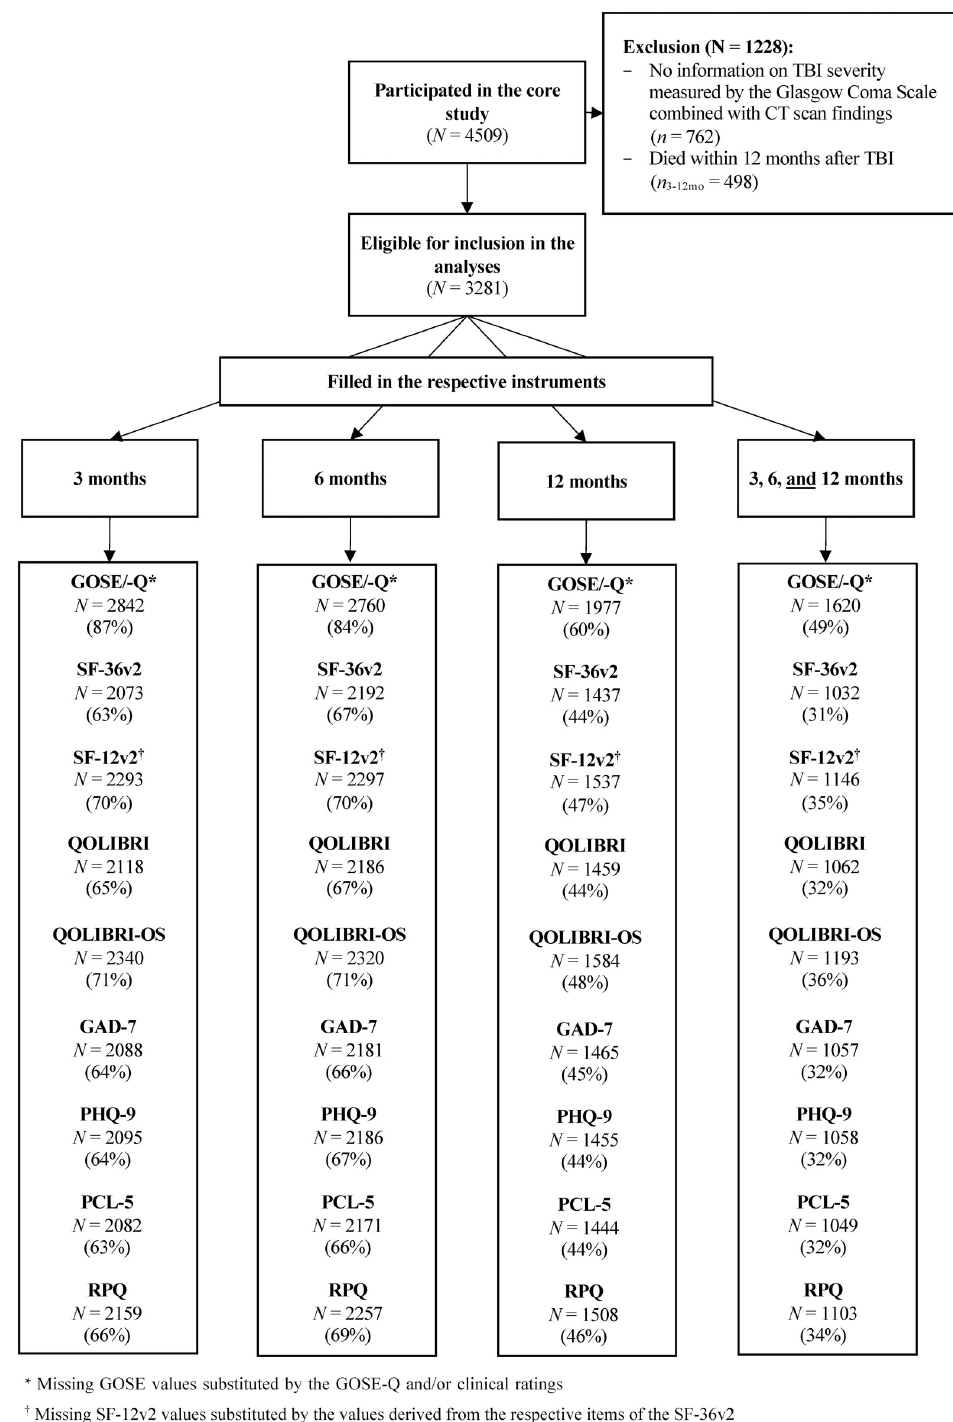
Fig 2. Numbers of completed instruments per time point (3, 6, and 12 months after TBI) and for all time points completed by the same individuals. GOSE/-Q = Combined information on recovery status using the Glasgow Outcome Scale–Extended and its questionnaire version; SF-36v2 = 36-item Short Form Health Survey–version 2; SF- 12v2 = 12-Item Short Form Survey–version 2; PCS = Physical Component Summary Score, MCS = Mental Component Summary Score; QOLIBRI = Quality of Life after Traumatic Brain Injury; QOLIBRI-OS = Quality of Life